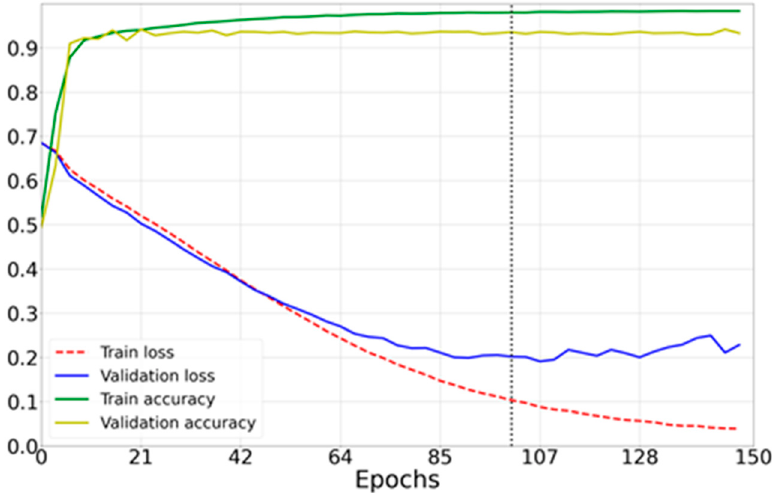
Figure 13. DenseNet169 model loss curves (green and yellow) and accuracy curves (blue and red). Figure 14 compares the results of accuracy, power consumption, and time spent on making one prediction, and Table 2 compares the error matrices.